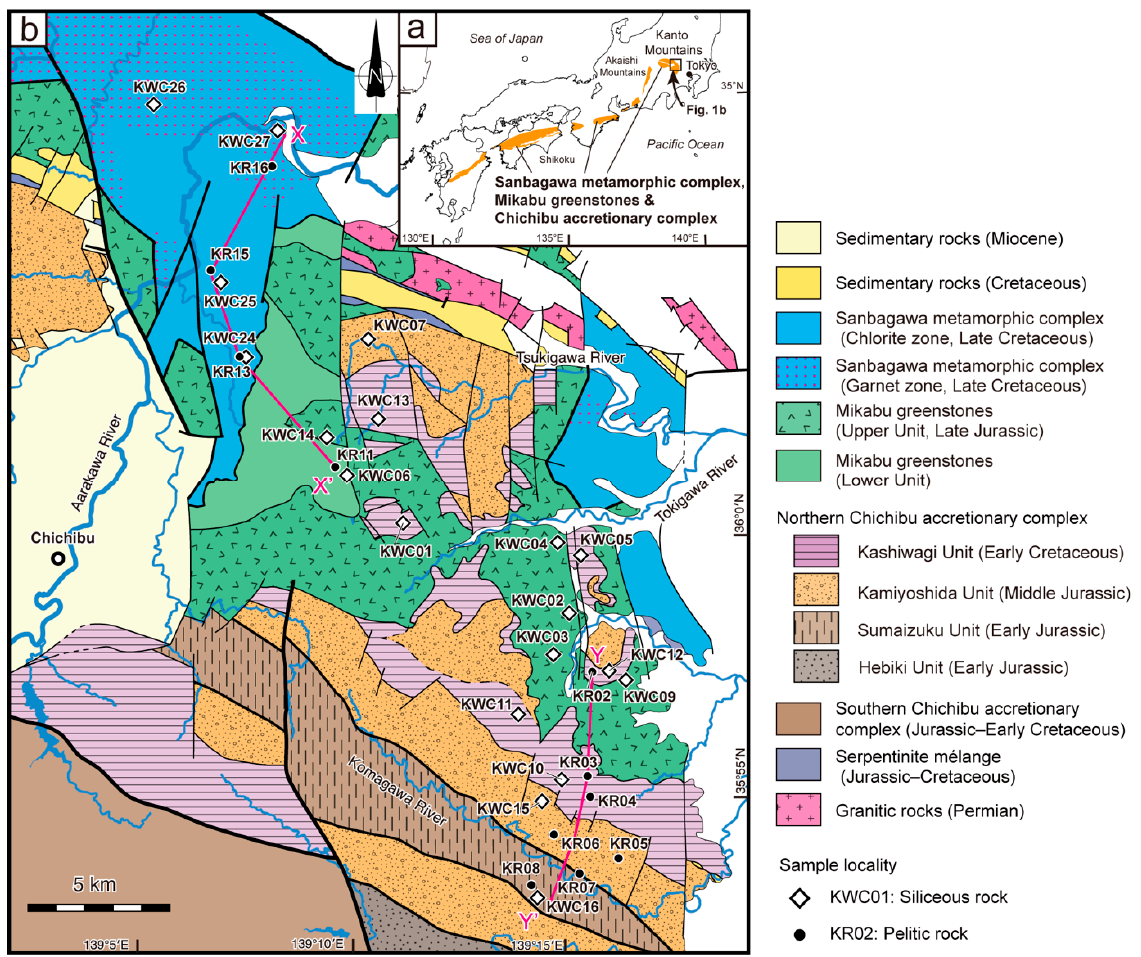
Figure 1. Geological outline of the study area: ( a ) map of central to southwest Japan showing the location of the Kanto Mountains and the distribution of the Sanbagawa metamorphic complex, the Mikabu greenstones, and the Chichibu accretionary complex [3,11] and ( b ) geological map of the eastern Kanto Mountains, modified from previous studies [3,11], showing the chert and pelitic rock sample localities. The geological transects X–X’ and Y–Y’ (pink lines) are shown in Figure 5.